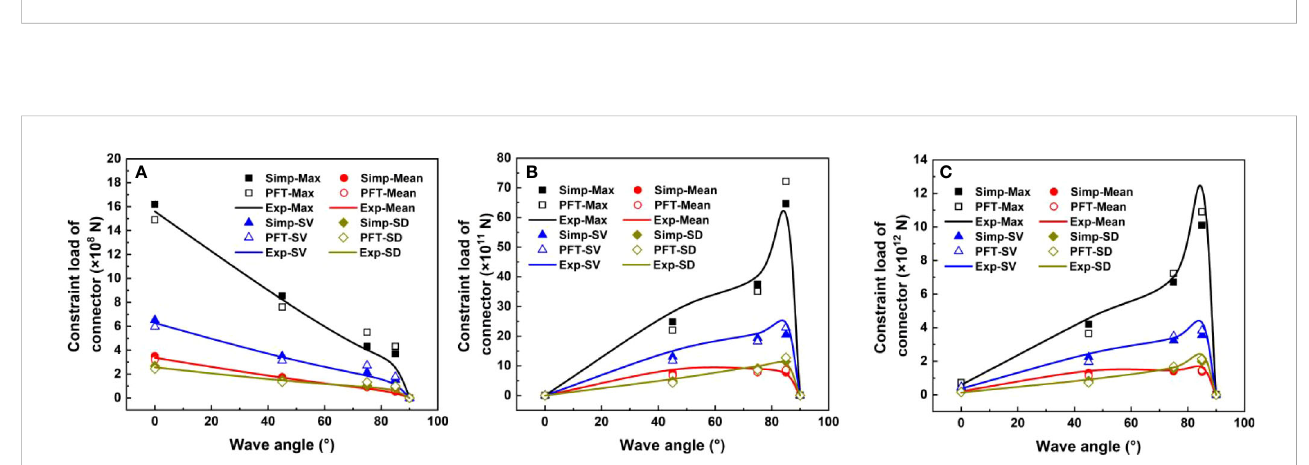
FIGURE 19 Constraint loads of C 3 : (A) x direction; (B) y direction; (C) c